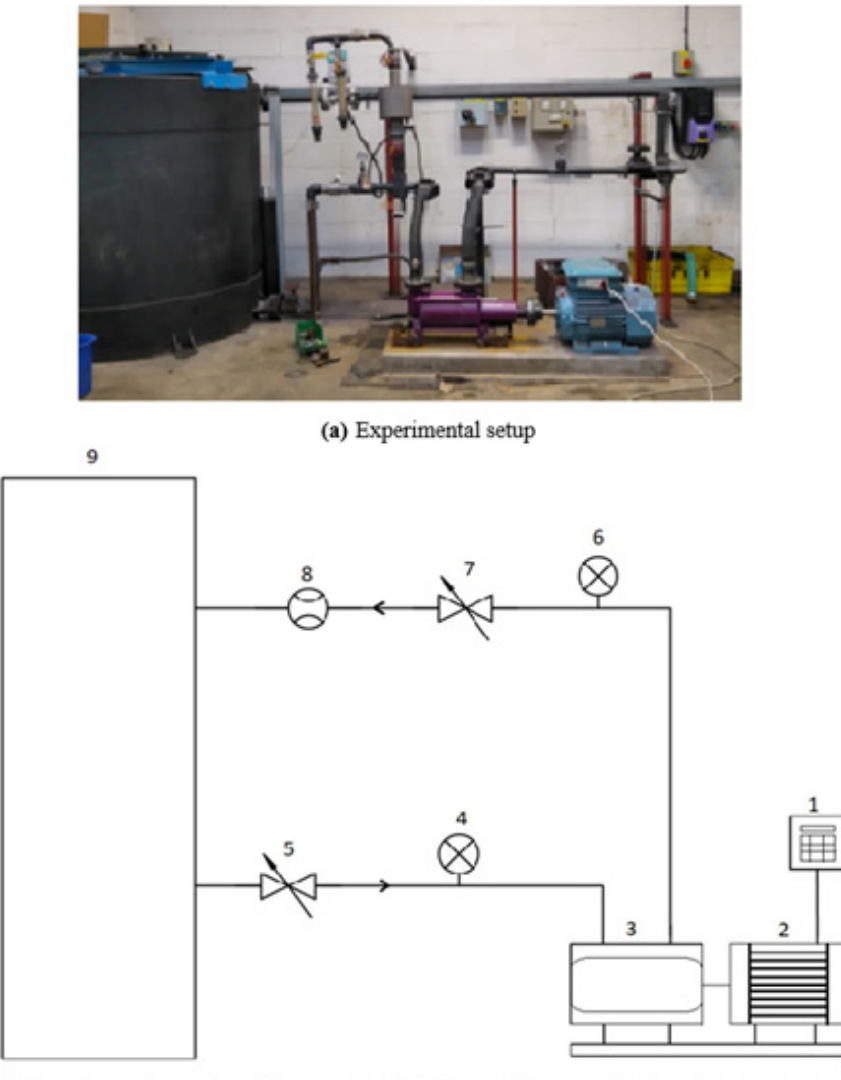
Figure 5. Testing Platform ( a ) Experimental setup ( b ) Schematic diagram of experimental set up.